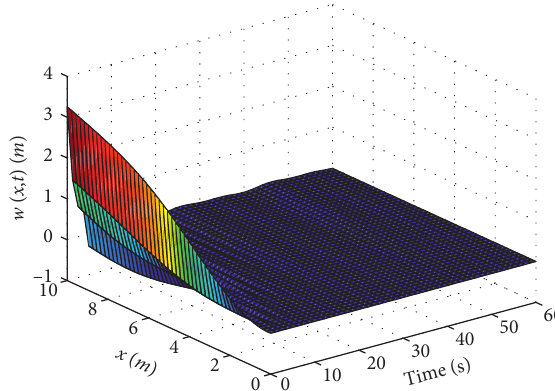
Figure 5: Deflection of the spacecraft with adaptive boundary control.